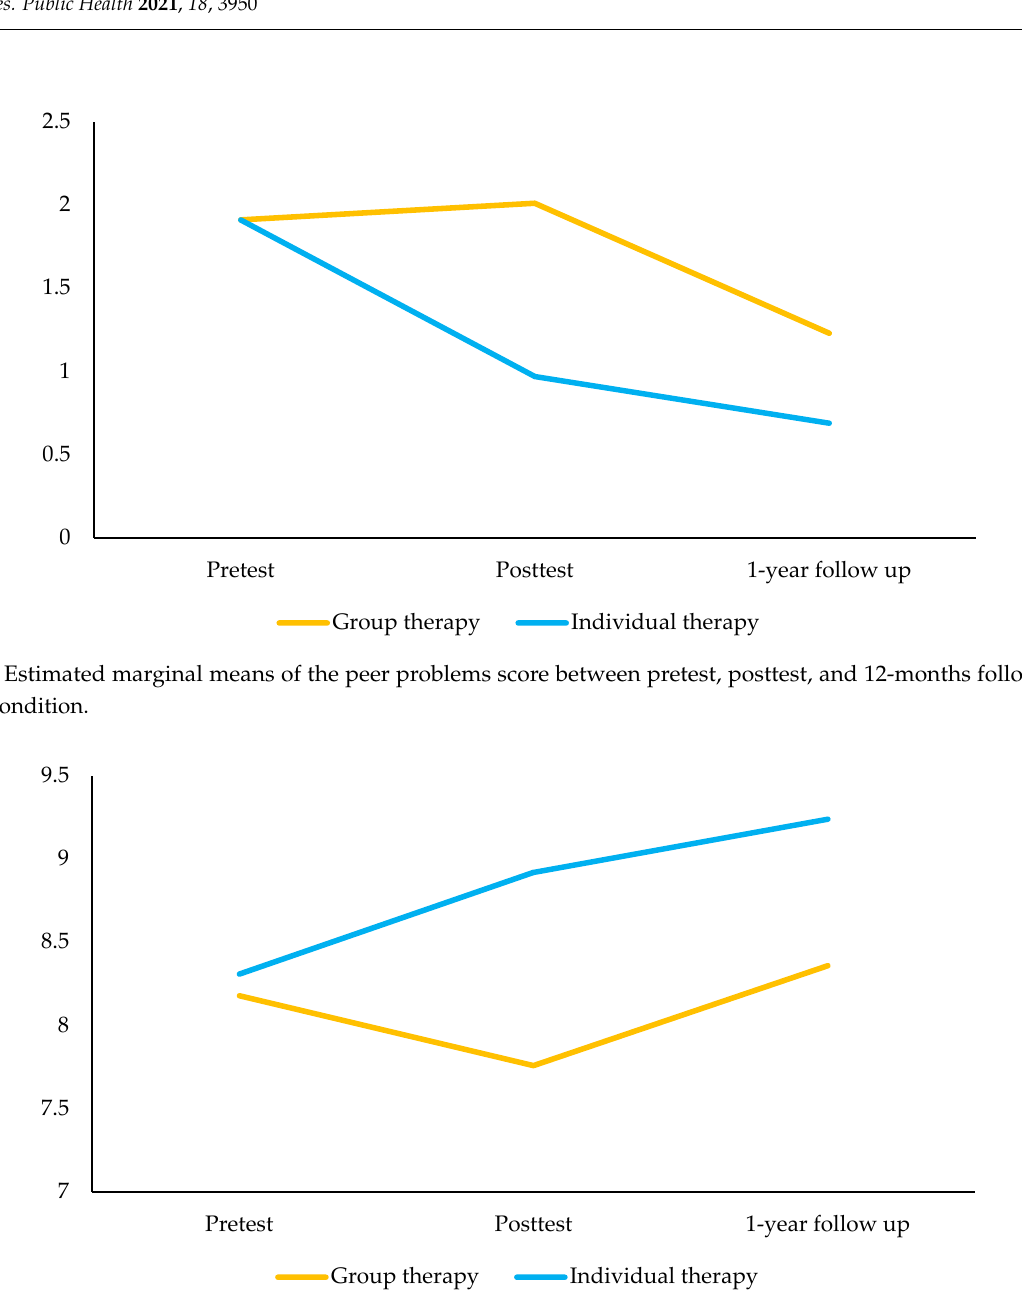
Figure 3. Estimated marginal means of the prosocial behavior score between pretest, posttest, and 12-months follow-up by therapy condition.